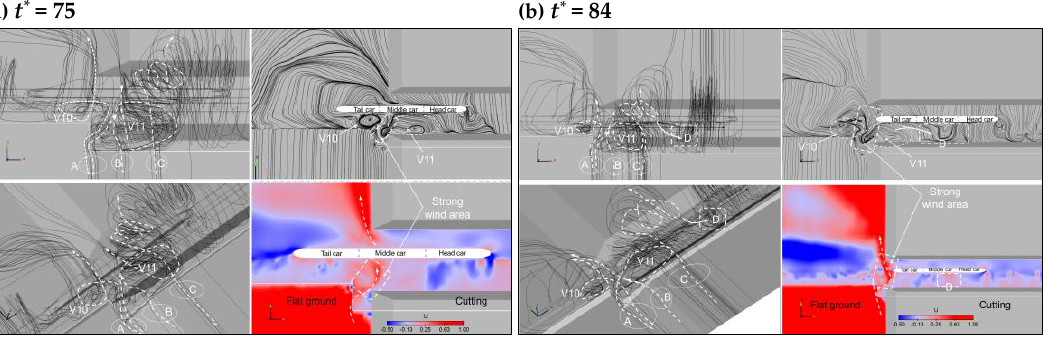
Figure 14. Flow structures and speed contours around the train at different times: ( a ) t* = 75 and ( b ) t* = 84.